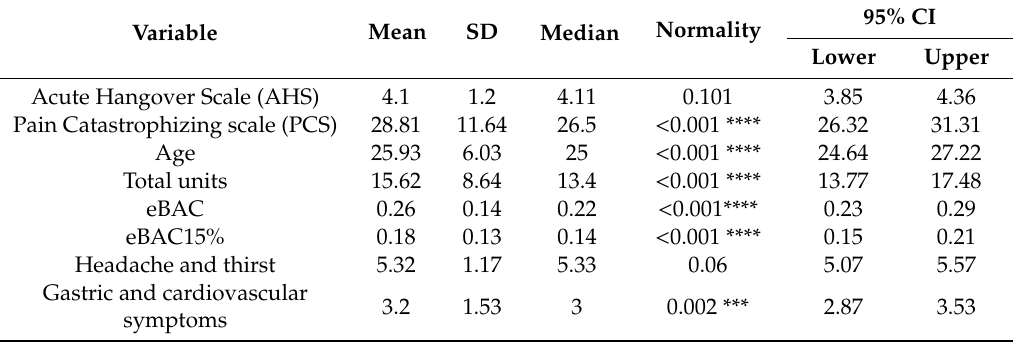
Table 4. Descriptive statistics for variables included across the five regression models constructed. Variable Mean